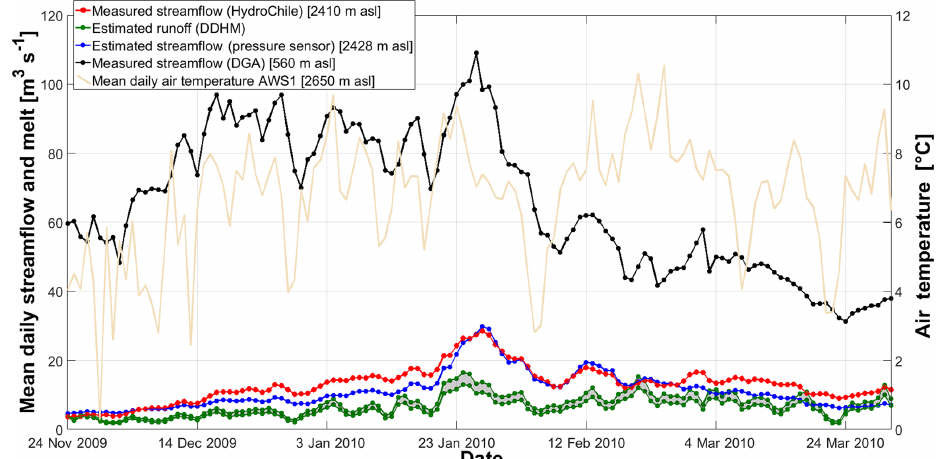
Figure 12. Daily mean melt from the distributed degree-hour model, and discharge measurements from the water level sensor, HydroChile station and DGA station. Mean daily air temperature at AWS1 is plotted on the right y